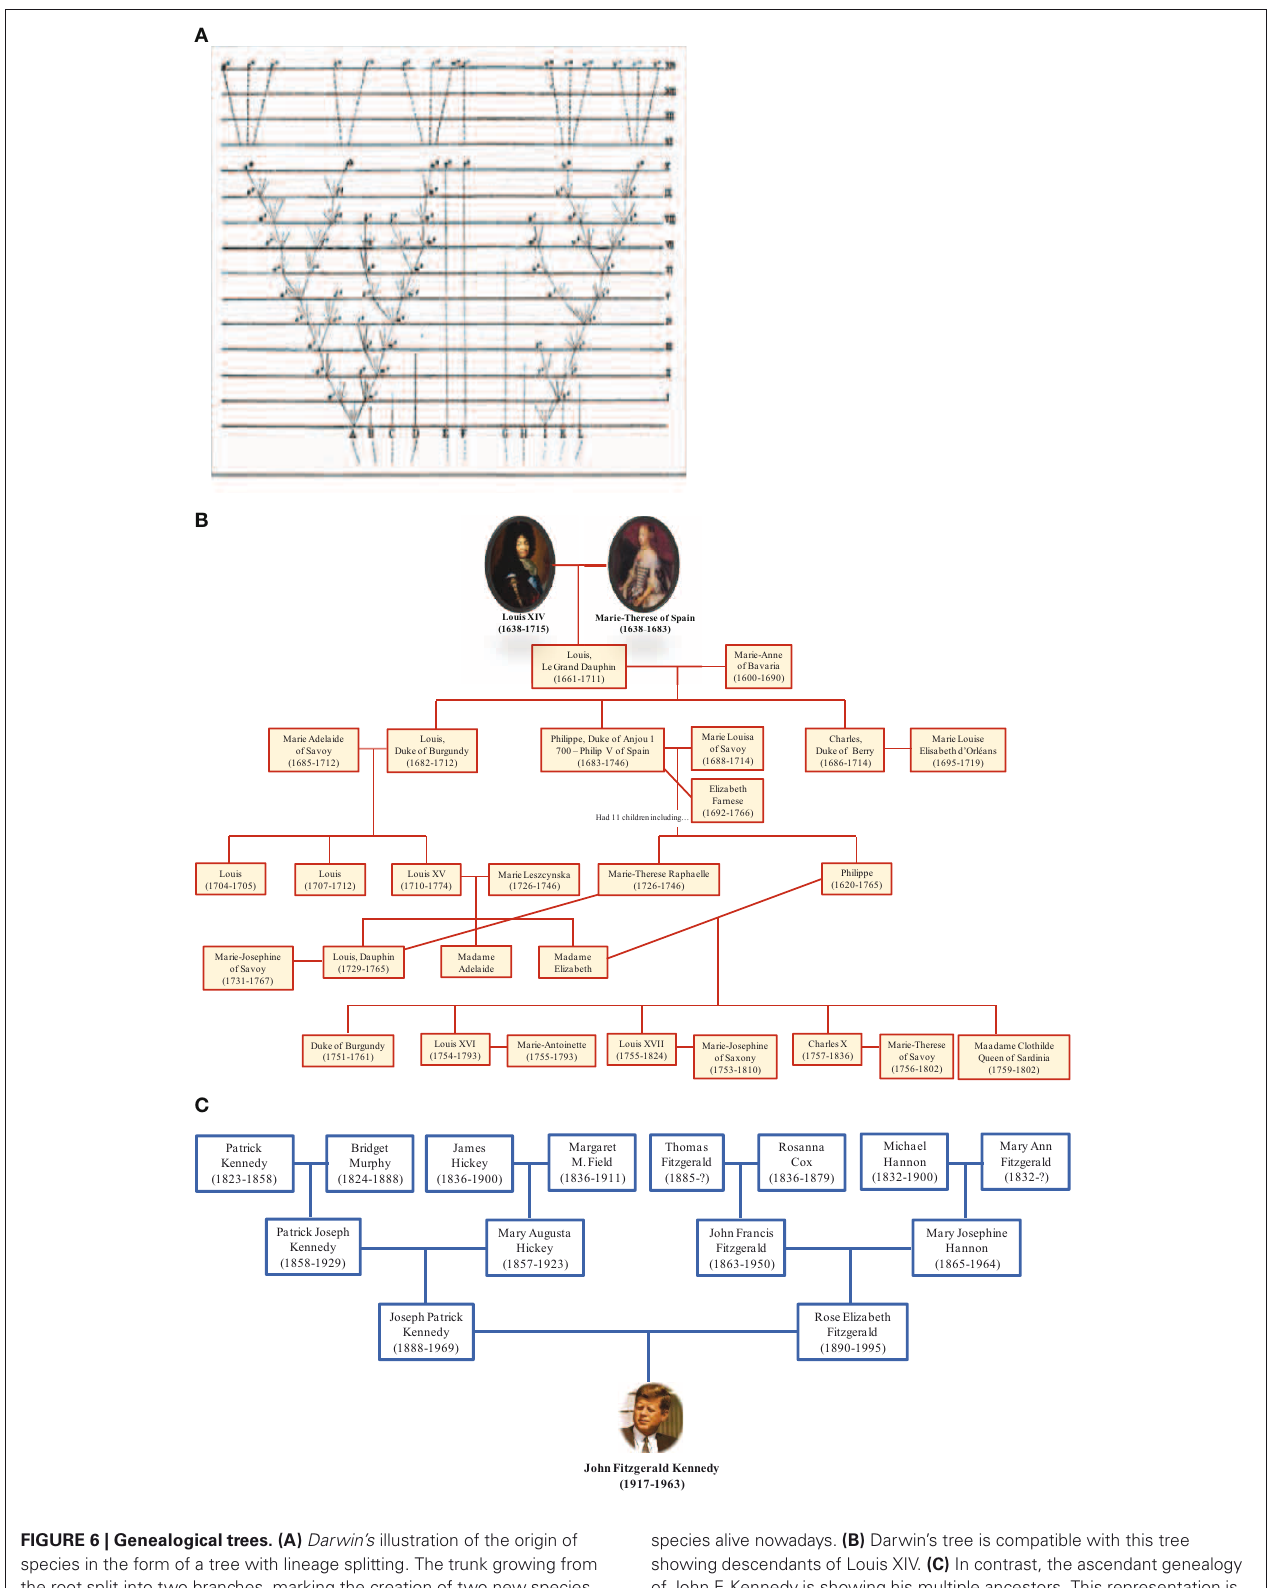
species alive nowadays. (B) Darwin’s tree is compatible with this tree showing descendants of Louis XIV. (C) In contrast, the ascendant genealogy of John F. Kennedy is showing his multiple ancestors. This representation is consistent with our current knowledge.